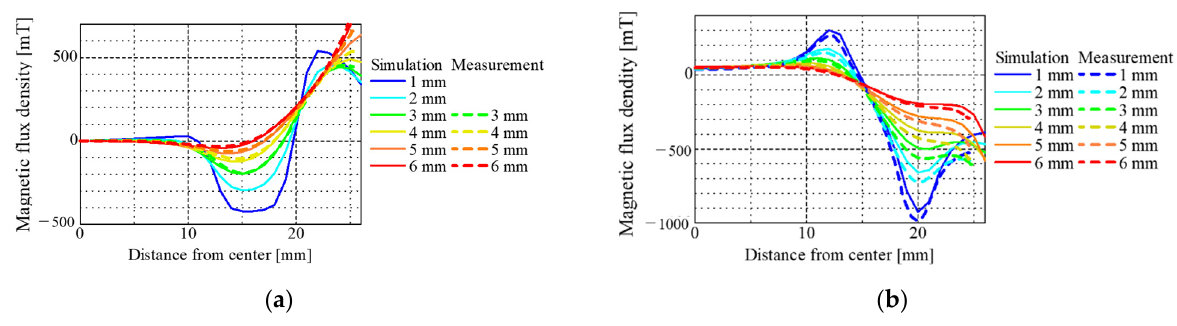
Figure 6. Comparison of magnetic flux density at the top of the HTS. ( a ) Radial simulation and measurement results, and ( b ) axial simulation and measurement results.